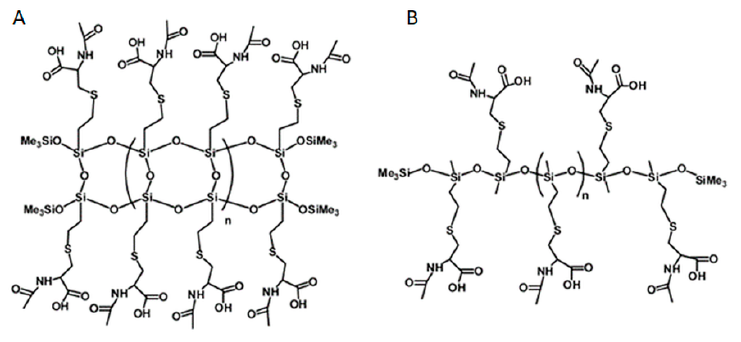
Figure 8. Chemical structures of NAC-Si-1 ( A ) and NAC-Si-2 ( B ) polymers.